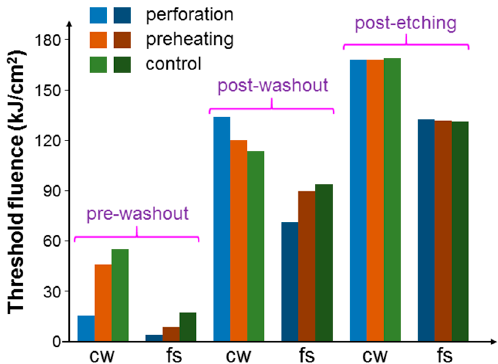
Figure 9. Threshold fluences similar to those in Figure 8 when cells were incubated with NRI-AlPcS. Molecules 2018 , 23 , x